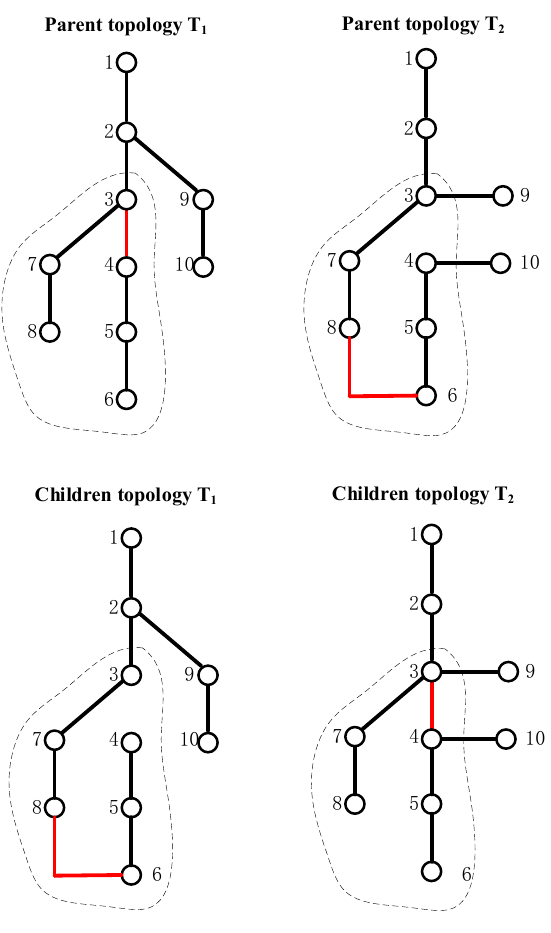
Figure 2. Crossover operation of network topology.